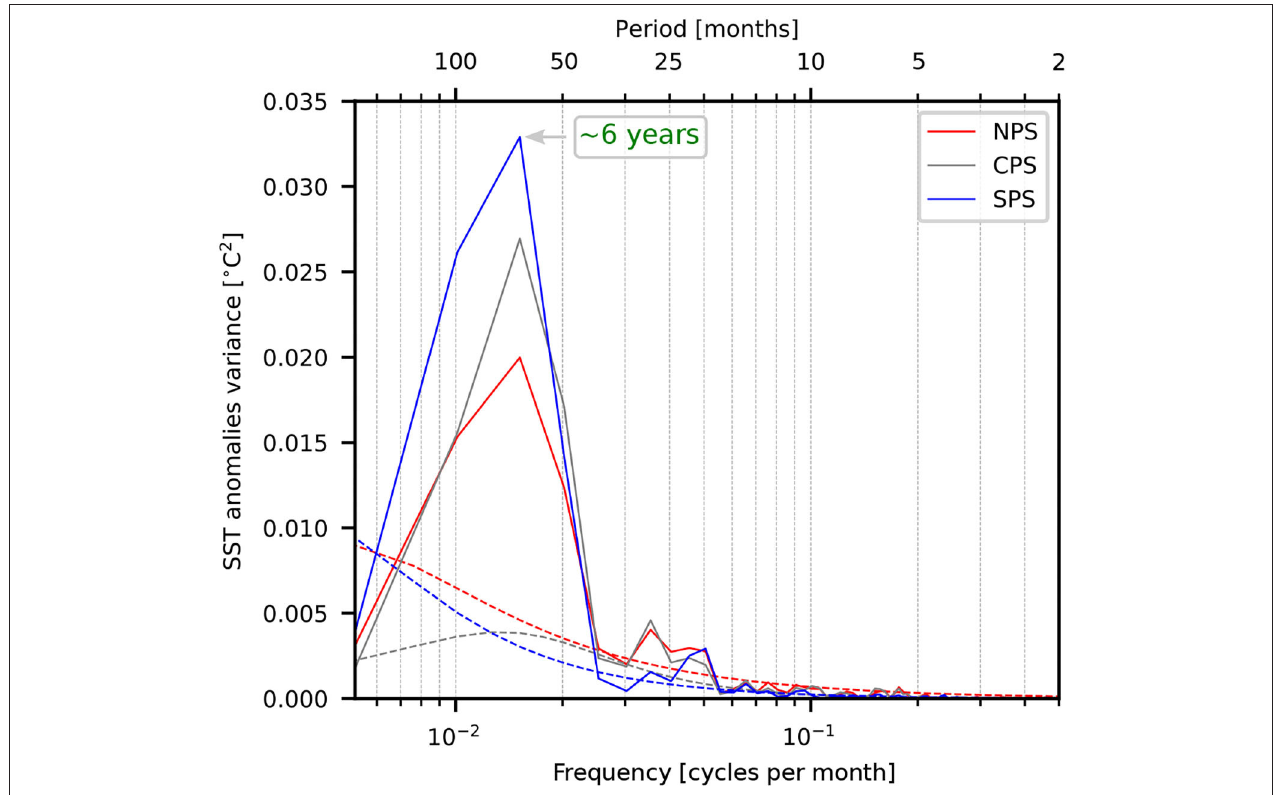
FIGURE 6 | Variance preserving Welch spectra of filtered and detrended SSTa time series (see Section 2.1) at NPS (solid red line), CPS (solid gray line) and SPS (solid blue line) shown in Figure 1B ). Dashed lines indicate the power spectral density of red noise for each spectrum. The dashed green line indicates the period of maximum variance centered at ∼ 6 years (see Section